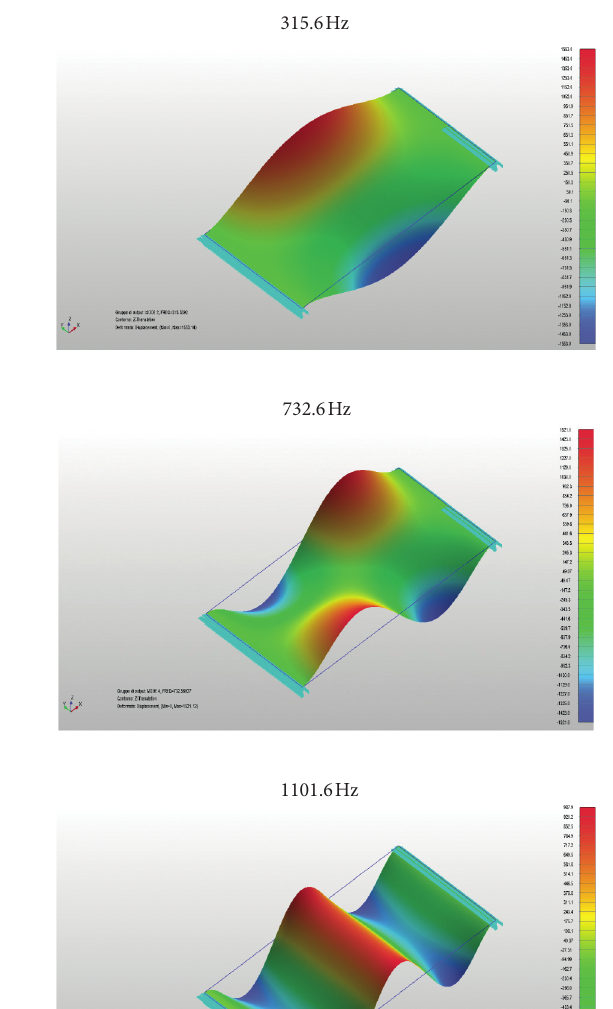
Table 4: FEM simulation: mode shapes and natural frequencies (Case